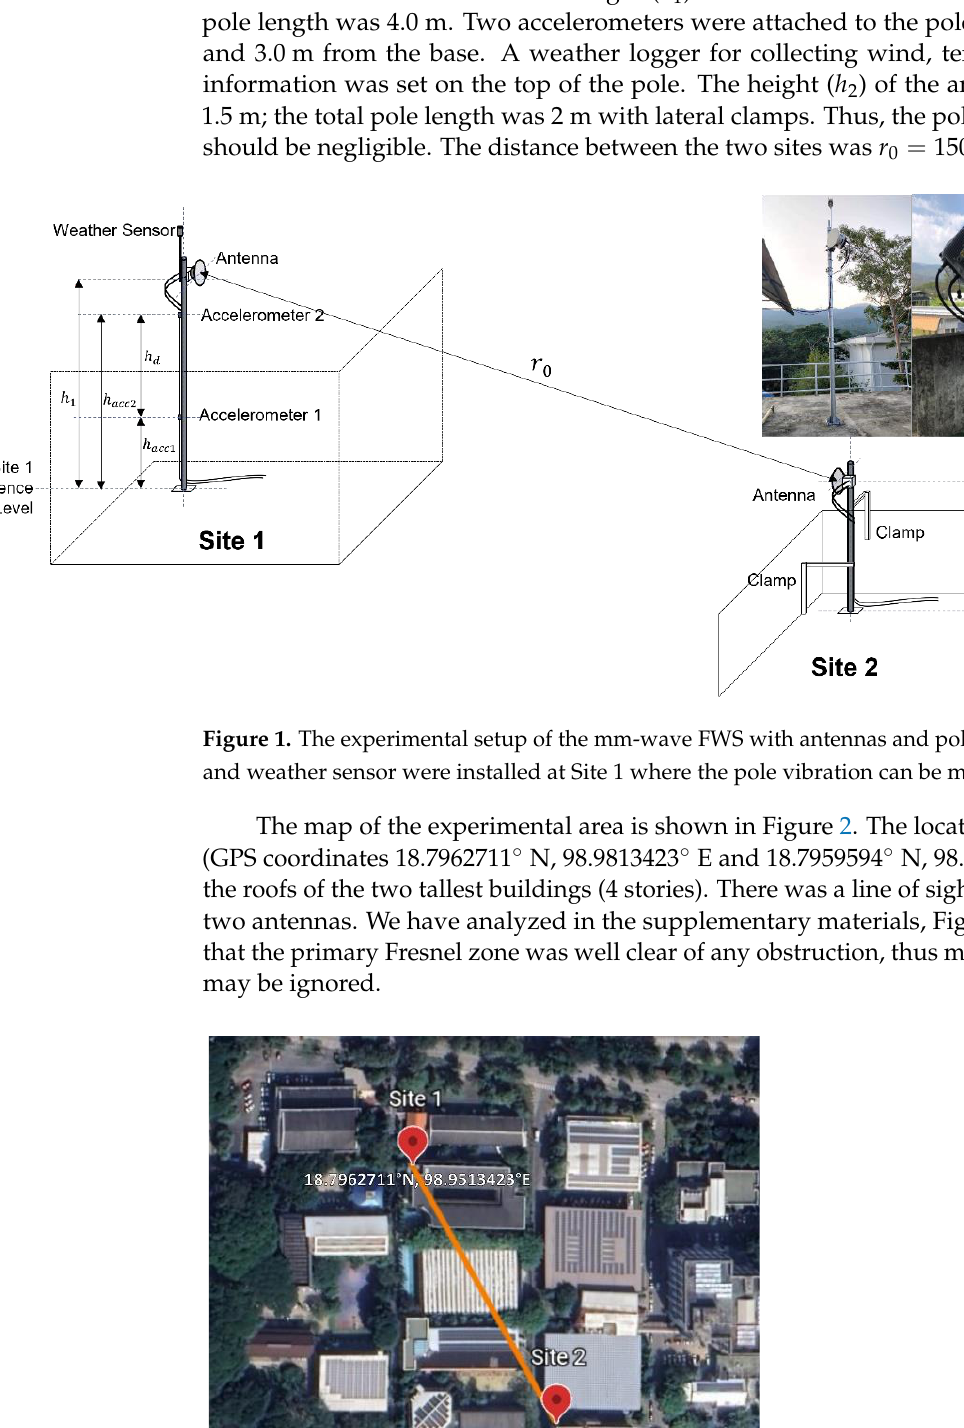
Figure 3. Schematic illustration of the antennas/sensors setup and block diagram of connections. The followings are the specifications of the equipment. The FWS unit is NEC iPASO- LINK EX Advanced, with a minimum Tx power of − 5 dBm and frequencies of 71 – 76 GHz and 81 – 86 GHz. The carrier frequency f = 74.625 GHz of the link from site 2 to site 1 was selected in the experiment. Automatic gain control (AGC) was turned off so that real-time attenuation due to weather effects could be measured. The antennas are COMMSCOPE- VHLP1-80 with a diameter of 0.3 m, beamwidth of 0.9°, 43.5 dBi gain, 14.0 dB return loss and a Voltage Standing Wave Ratio (VSWR) of 1.50. The total weight of each antenna and its mounting bracket is 7 kg. The pair of accelerometers (IMV-VP-8013M) measured 3-axis accelerations with a sensitivity of 44.9 mV/(m/s 2 ). Their responses are in a range of 0.04 – 1000 Hz. The maximum measurable acceleration is ±58.8 m/s 2 . The RSSI level from the FWS unit and accelerometer data were sampled via the data logger (GRAPHTEC-GL980 midi LOGGER) at 10 ms intervals. Each data logger input has a 16-bit ADC with 0 – 30 V input range and 0 – 200 kHz frequency response. The weather sensor (VAISALA-WXT536), located at site 1, can measure barometric pressure, air temperature, relative humidity, precipitation, and wind. The precipitation sensor has a collection area of 60 cm 2 and can measure the rain rate in a range of 0 – 200 mm/h. Each value of the rain rate is a running 1-min average in 10-s intervals. The wind sensor can measure the wind speed in the range 0 – 60 m/s at a resolution of 0.1 m/s, with a response time of 0.25 s. Wind direction information can also be gathered with ±3° accu- racy at 10 m/s. The weather sensor data were sampled at 10-s intervals using a Raspberry Pi.